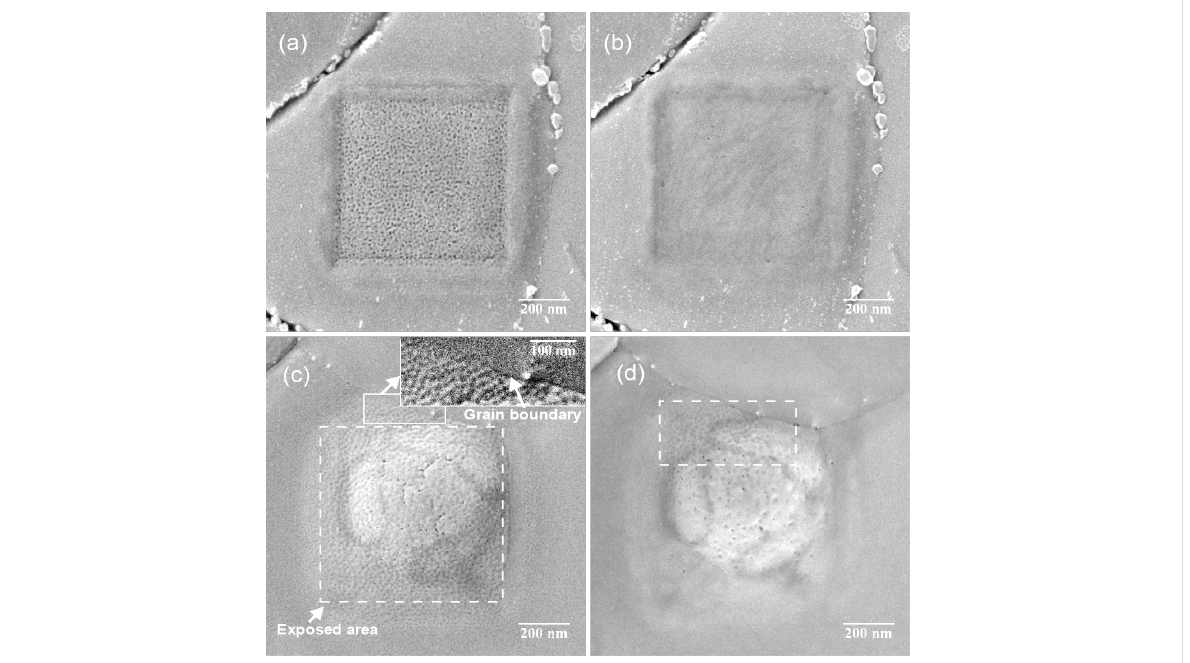
Figure 1: HIM SE image of a Au{111} surface, exposed to a He + beam with a fluence of 8.4 × 10 17 cm − 2 at different energies. The field of view (FOV) is 1.25 μ m, pixel spacing is 1.5 nm. (a) Porous structure formed by a 15 keV He + beam. (b) The same area as in image (a) after 1.5 months storage under dry atmospheric conditions. The surface has partly self-annealed. (c) Blister formed by a 35 keV beam. The area exposed to the beam is marked by a dashed line. The surface has developed a periodic pattern. The influence of the beam is easily visible outside the marked area as well, but does not extend on the neighboring grain (see inset). (d) The same area as in (c), imaged after 4 months storage under dry atmospheric condi- tions. The surface of the blister has partly self-annealed, except the marked area in the vicinity of the grain boundary.